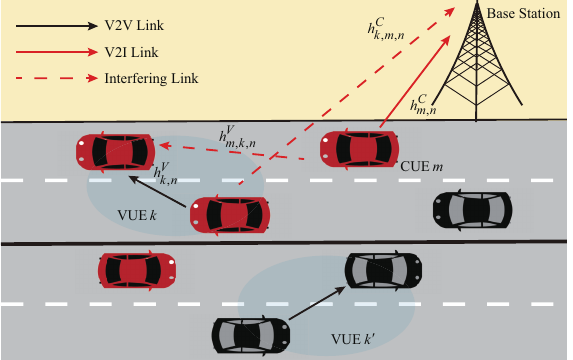
Figure 1. C-V2X mode 3 communication